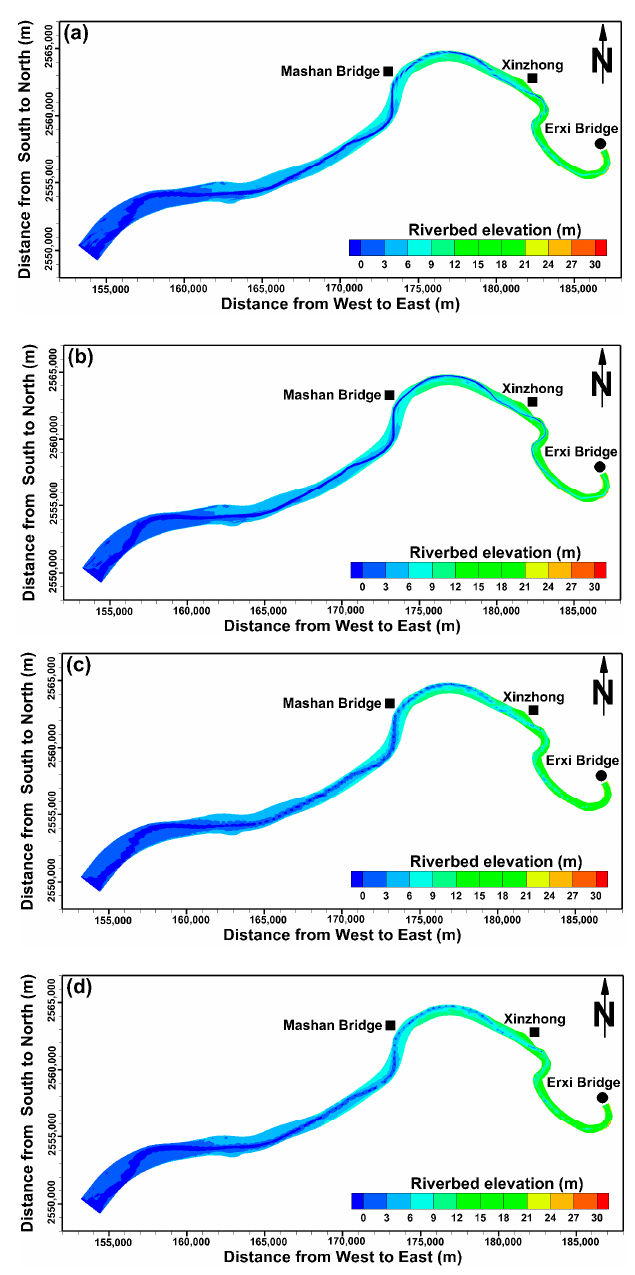
Figure 4. High resolution unstructured grids in the Tsengwen River for hydrodynamic modeling.